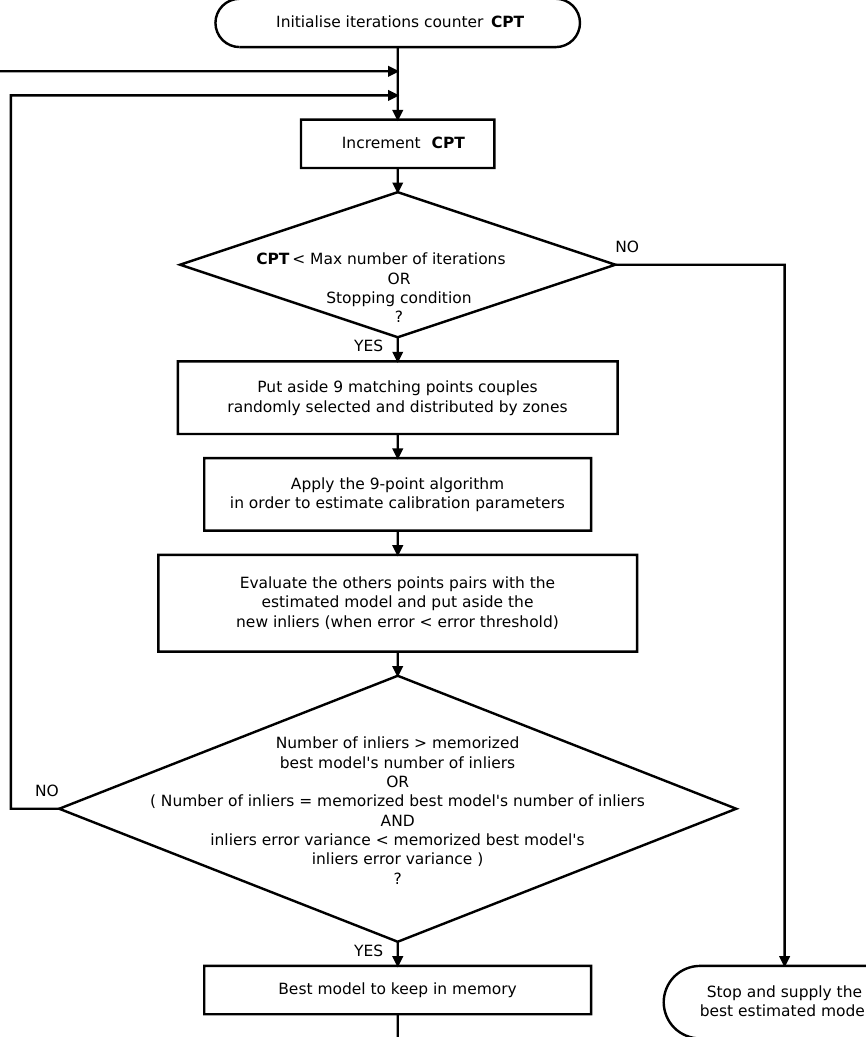
Figure 7. Pseudo-algorithm of the RANSAC (RANdom SAmple Consensus) strategy containing the 9-point